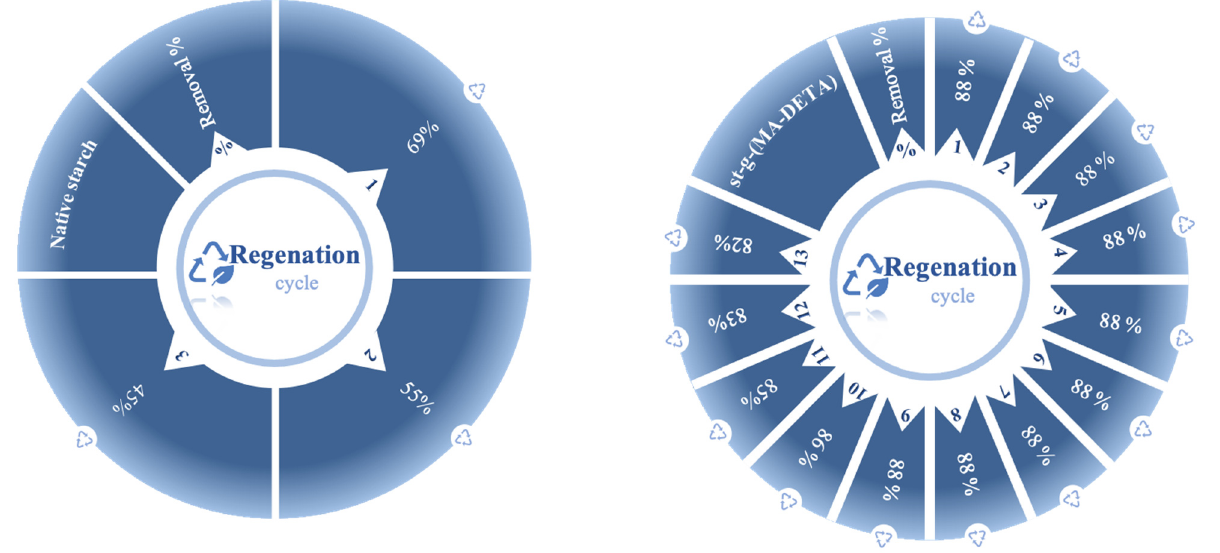
Figure 17. The effects of multicyclic regeneration on the rate of CB removal by different adsorbents (starch and St-g-(MA-DETA)) (10 ppm, 7pH, 0.03 g, 30 and 120 min).